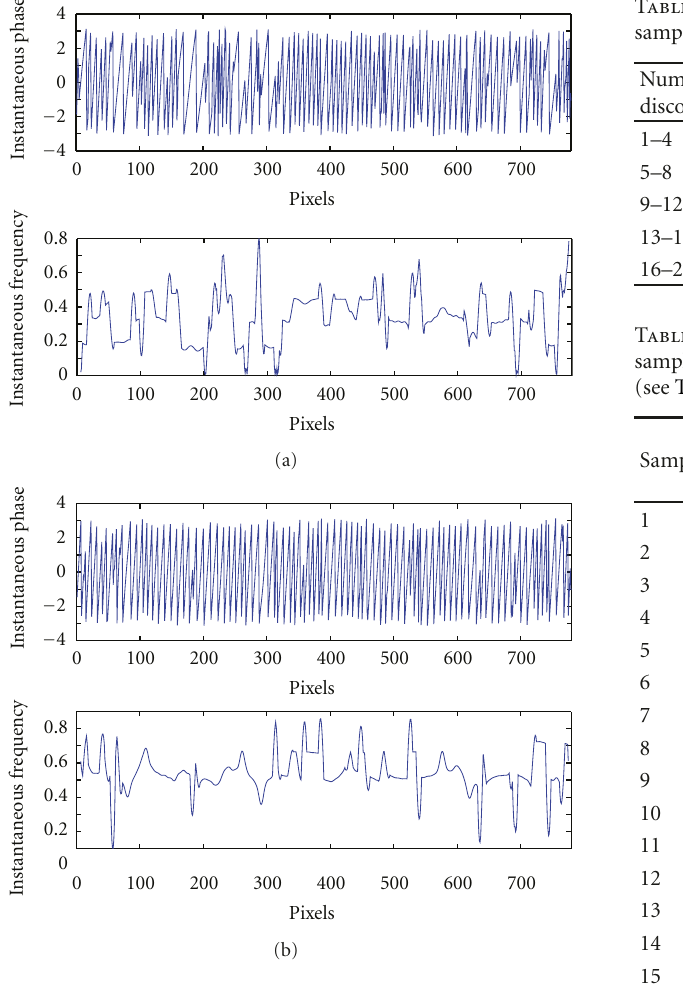
Figure 14: Radial instantaneousphaseand instantaneousfrequency magnitude using (a) variable frequency spacing method, and (b) uniform wavelength spacing method. The input image is the populus sample of Figure 12(a). The example shows strong IF magnitude variation.